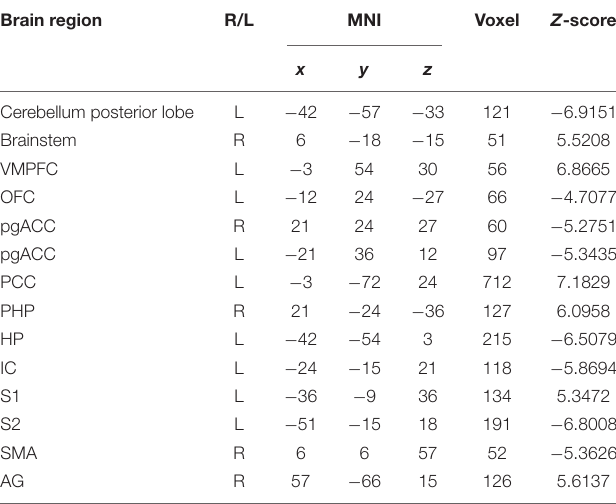
TABLE 2 | Summary of the brain areas indicating functional connectivity with the rACC in placebo response in male participants ( p < 0.05, FDR < 0.05). Brain region